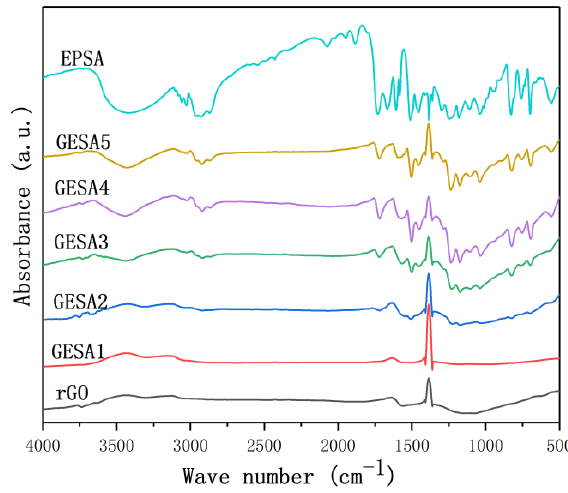
Figure 1. FTIR spectra of reduced graphene oxide (rGO), graphene oxide-epoxy grafted poly(styrene-co-acrylate) composites (GESA)1, GESA2, GESA3, GESA4, GESA5, and epoxy modified poly(styrene-co-acrylate) (EPSA).